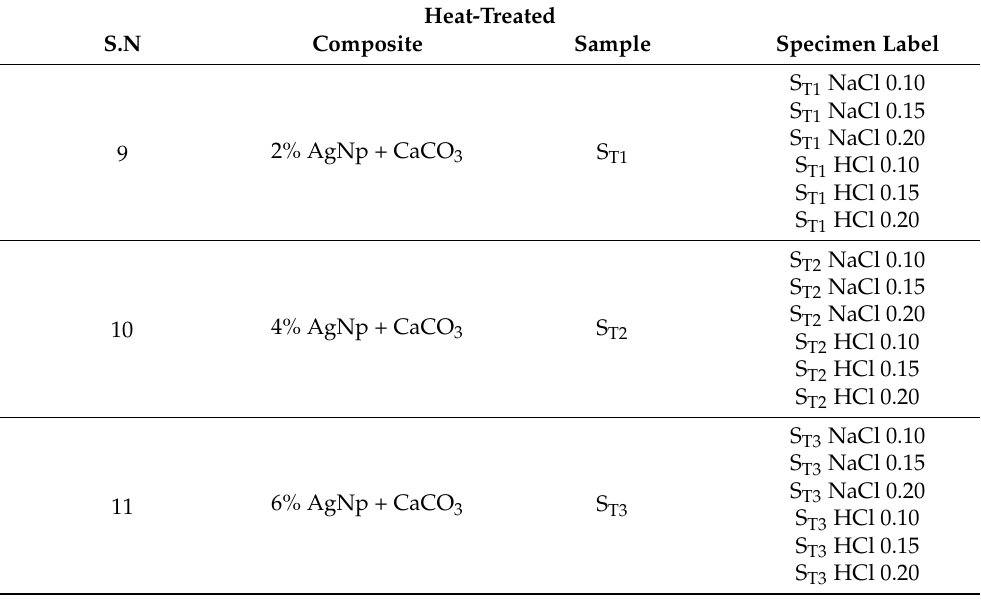
Table 5. Labels and weight of heat-treated AgNp + CaCO 3 specimens.